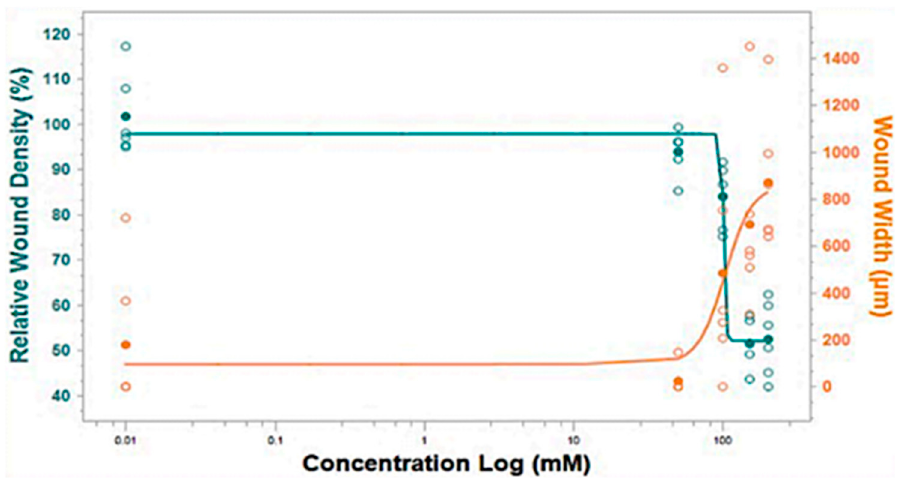
Figure 10. IncuCyte S3 live cell system (10×) live cell images analysis shows IC50/EC50 curves of the inhibition of cells’ proliferation and the efficiency of carnosine in killing the tumour cells. Upon carnosine exposure at different concentrations (0, 50, 100, 125 mM) over 48 h, the IC50 is indicated by the relative wound density, while the EC50 is the wound width. The images and videos of scratch wound healing by cell migration are available in the Supplementary Materials.